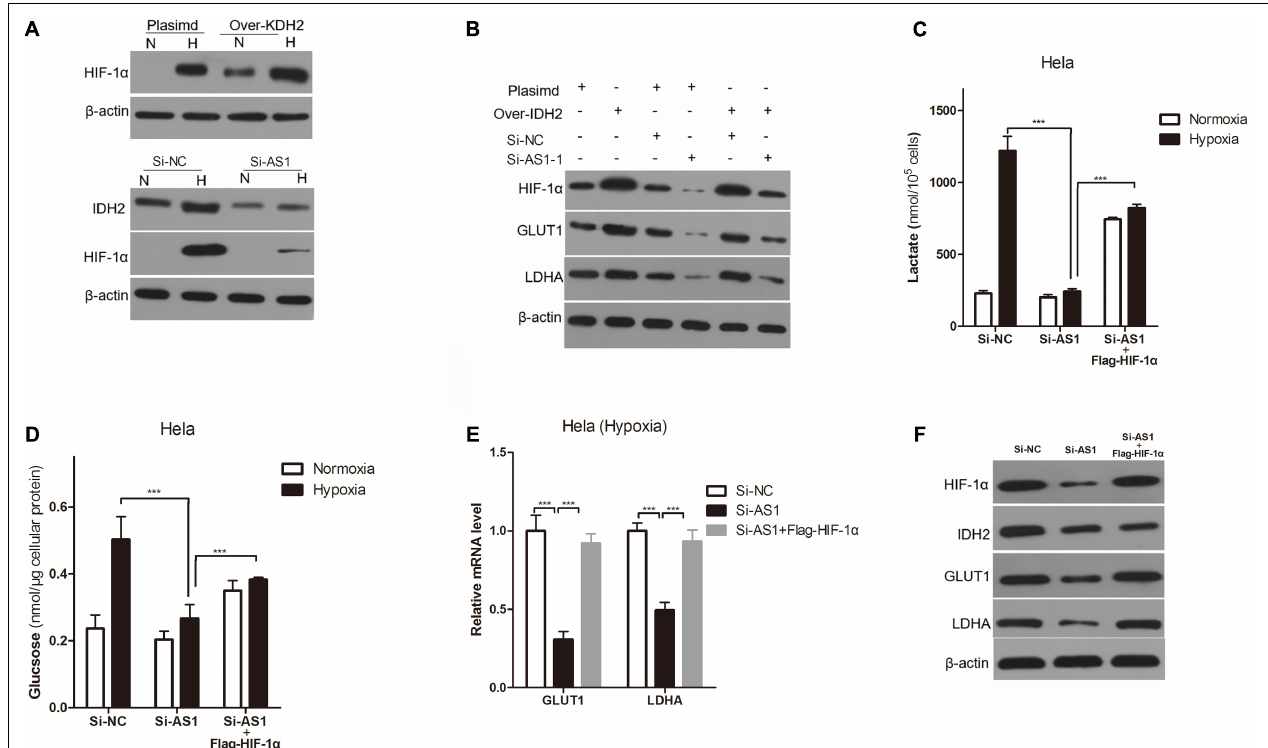
FIGURE 7 | OIP5-AS1 regulates the Warburg effect through IDH2 is HIF-1 α dependent. (A,B) Levels of IDH2, HIF-1 α , GLUT1, and LDHA protein expression in Hela cells using western blot. (C–F) Levels of lactate (C) in the culture medium and intracellular glucose (D) of Hela cells after culturing for 24 h under hypoxia, and RT-qPCR indicated GLUT1/LDHA mRNA levels, western blot analysis showed IDH2, HIF-1 α , GLUT1, and LDHA protein expression. Data were shown as mean ± SD of three individual experiments. P value was calculated by post hoc comparisons. *** P < 0.001.